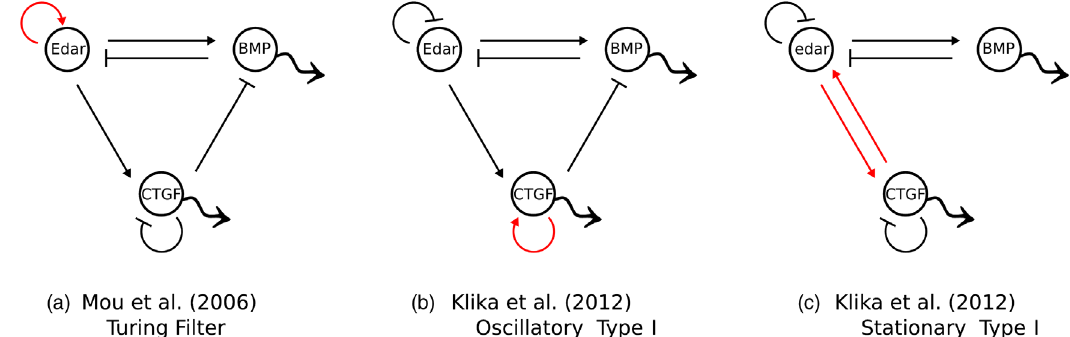
FIG. 13. Three alternative models of hair follicle patterning proposed by (a) Mou el al. [60] and (b),(c) Klika et al. [23]. They form a Turing filter, an oscillatory Turing network of type I, and a stationary Turing network of type I,